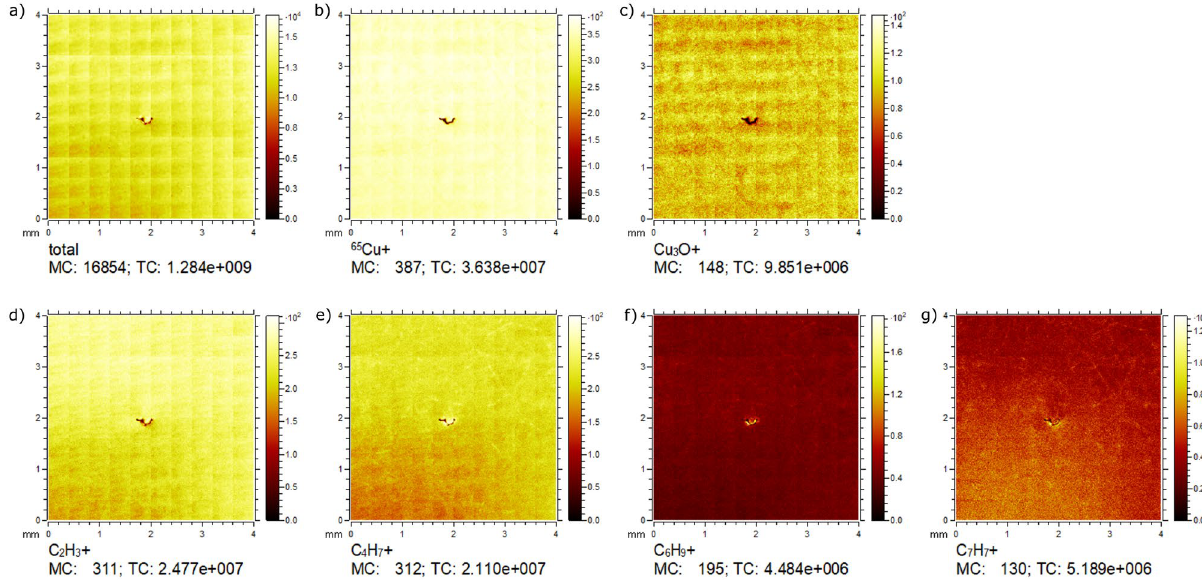
Figure 4. Lateral distribution maps of selected positive secondary ion intensities as macro raster 4 × 4 mm 2 show a homogeneous allocation: ( a ) total positive secondary ions, ( b ) 65 Cu + , ( c ) Cu 3 O + , ( d ) C 2 H 3 + , ( e ) C 4 H 7 + , ( f ) C 6 H 9 + and ( g ) C 7 H 7 + . An accidental particle contaminant was used for adjustment and the grid structure is an artefact of measurement in stitching